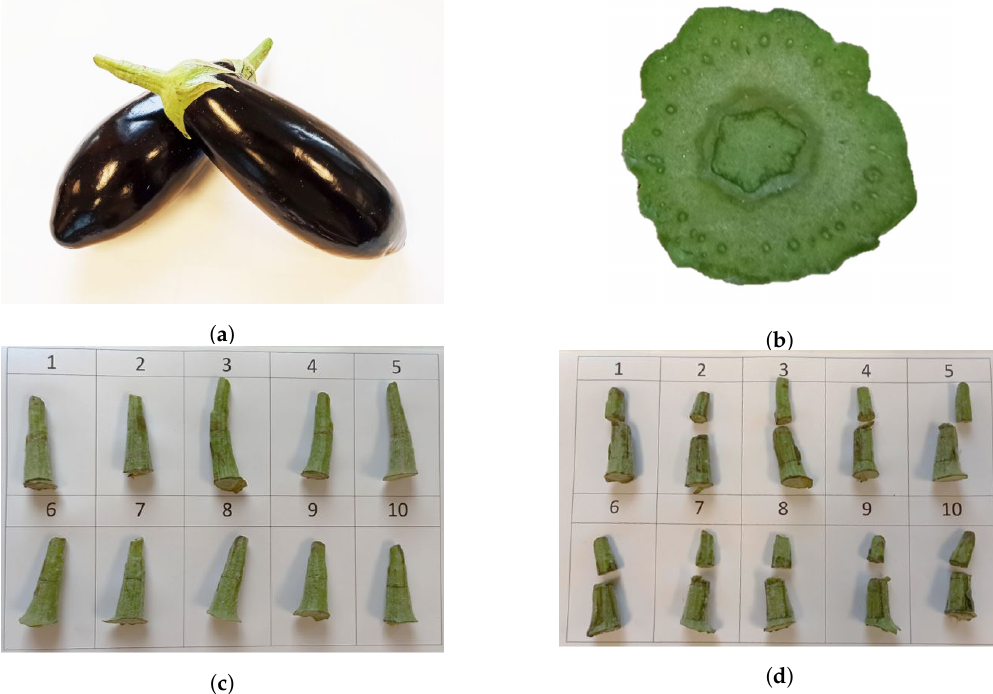
Figure 9. Aubergine cutting experiment. ( a ) Aubergines. ( b ) Peduncle transverse section view. ( c ) Series before the cutting experiment. ( d ) Series after the cutting